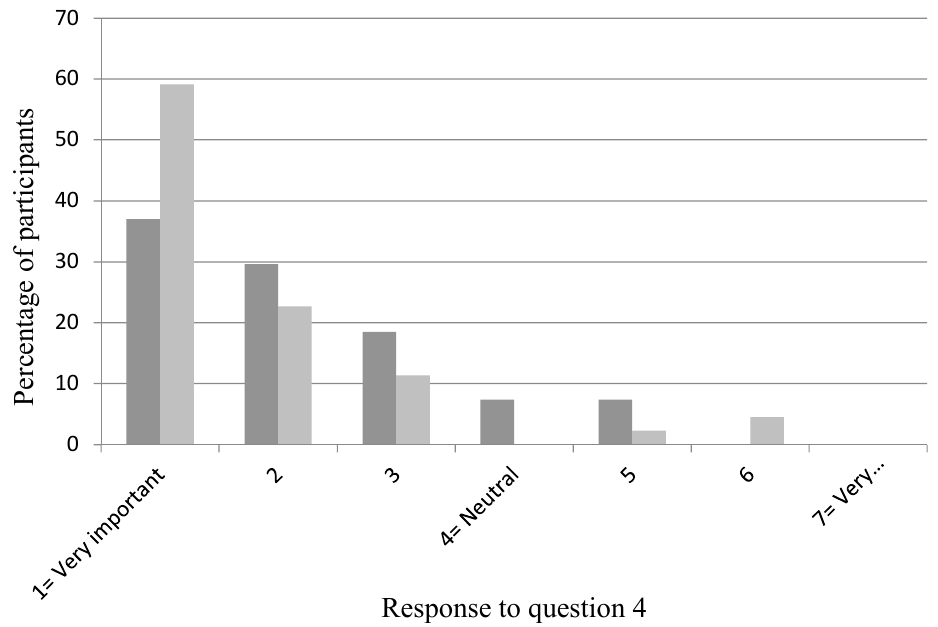
Figure 7. Male and female participants’ response to Question 4: “How important do you perceive the edentulous patient ʹ s values (beliefs, priorities, preferences) to be in making treatment decisions?”.